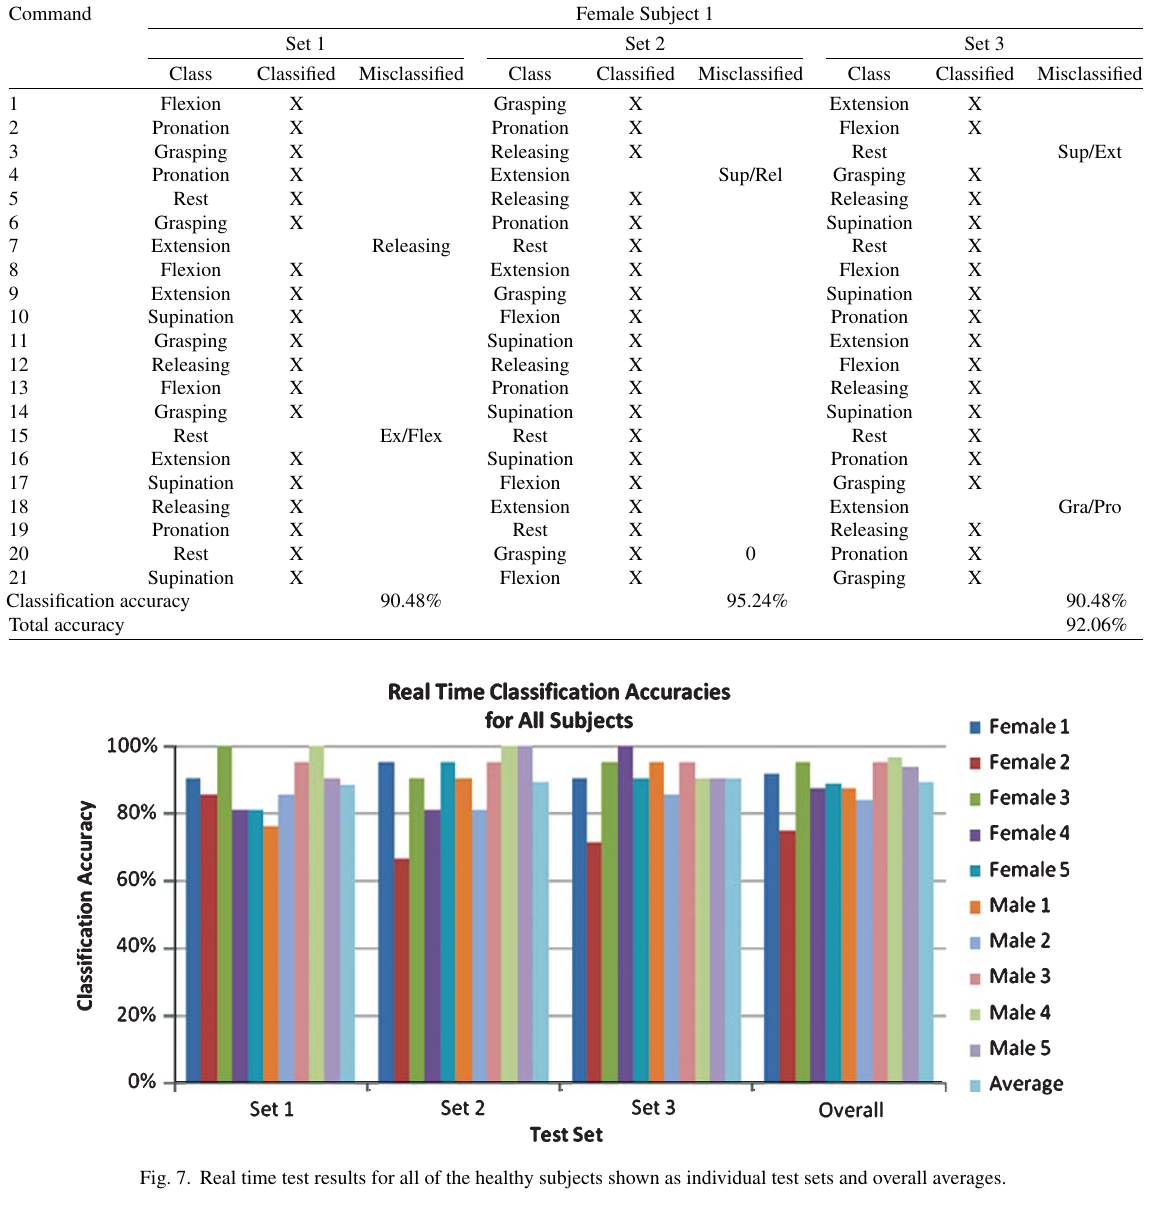
Table 1 Randomized commands given to all subjects for testing of the real time myoelectric control scheme and the results for the first female subject